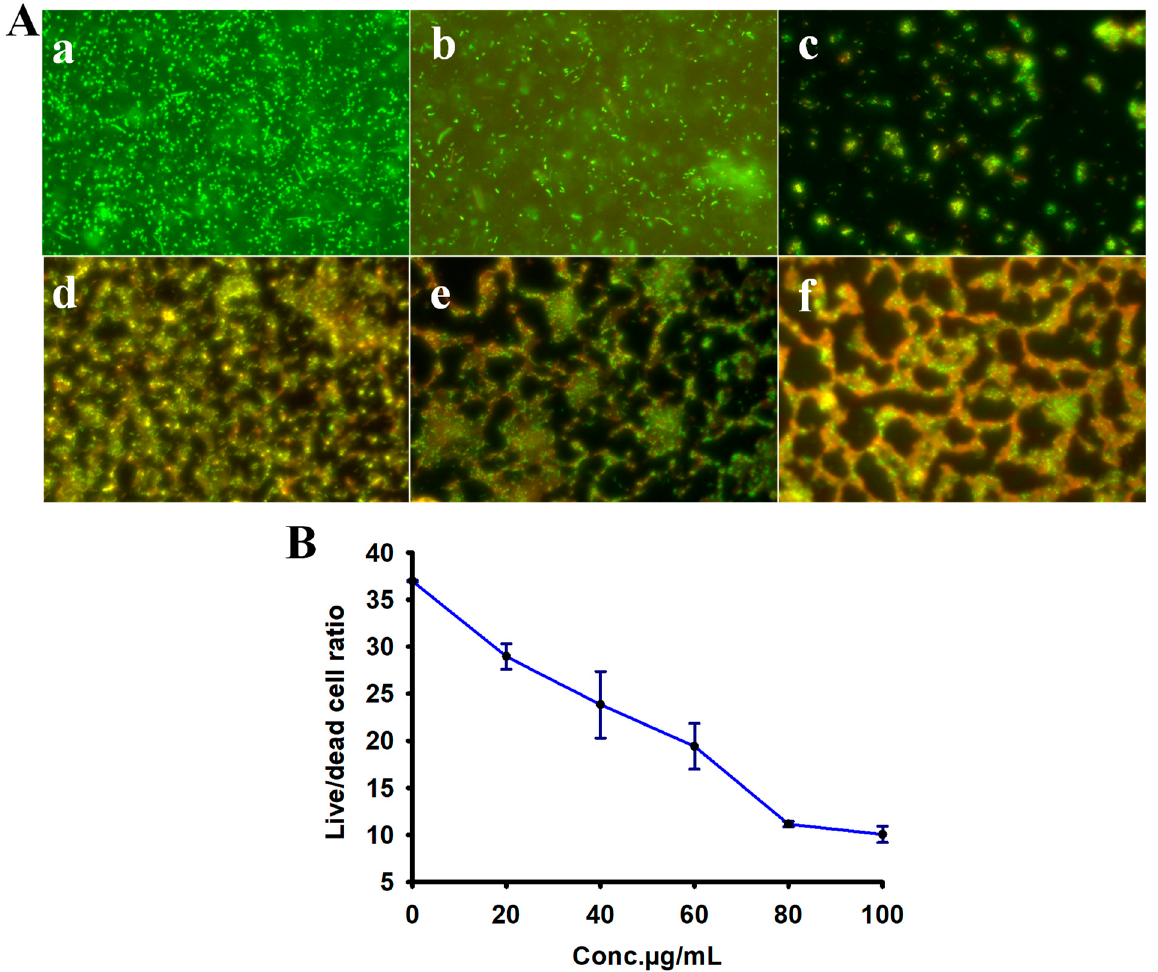
Figure 6. ( A ). Microscopic of bacterial samples were stained with PI and SYTO9. (a) Control, (b) 20 µg/mL, (c) 40 µg/mL, (d) 60 µg/mL, (e) 80 µg/mL and (f) 100 µg/mL of Cp-AgNPs. Staining was performed for Live/Dead with Baclight bacterial kit and the assay was calculated by number of live (green) and dead (red) cells ratio ( B ). The experiments indicate 24 h of treatment of Cp-AgNPs ex- posure on bacterial cells. All biofilm samples were homogenized before microscopic observation (40X).